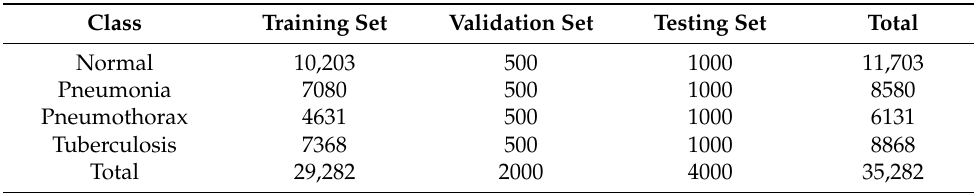
Table 2. SCH data set.